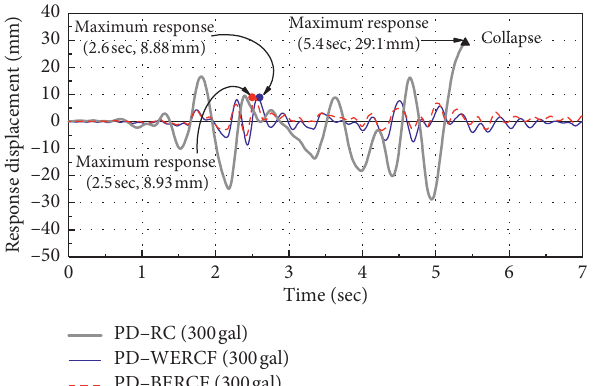
Figure 16: Response displacement-time history relationships of the control specimen and ESRCF-strengthened specimens during pseudodynamic testing at 300 gal.